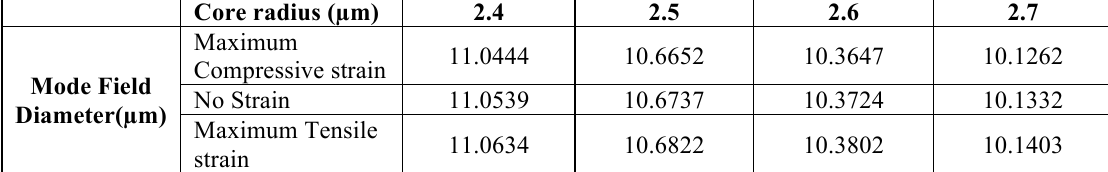
Table 1: Mode field diameter value for fiber with different core radiuses corresponding to specific strains at 1.55 µ m.